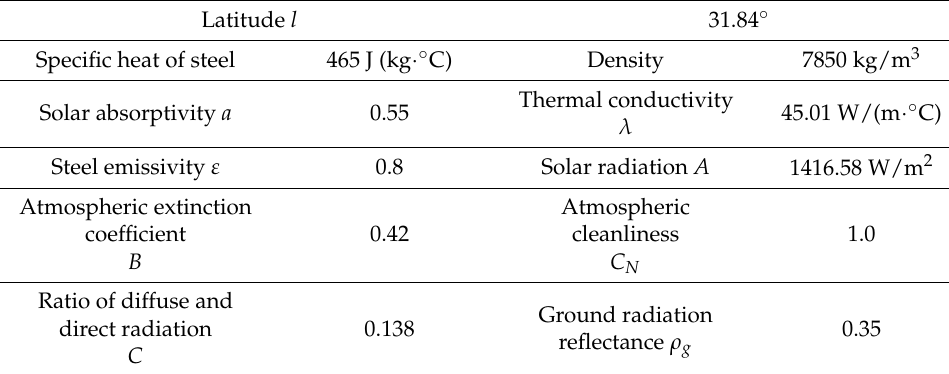
Table 1. Thermal parameters for steel and other properties.